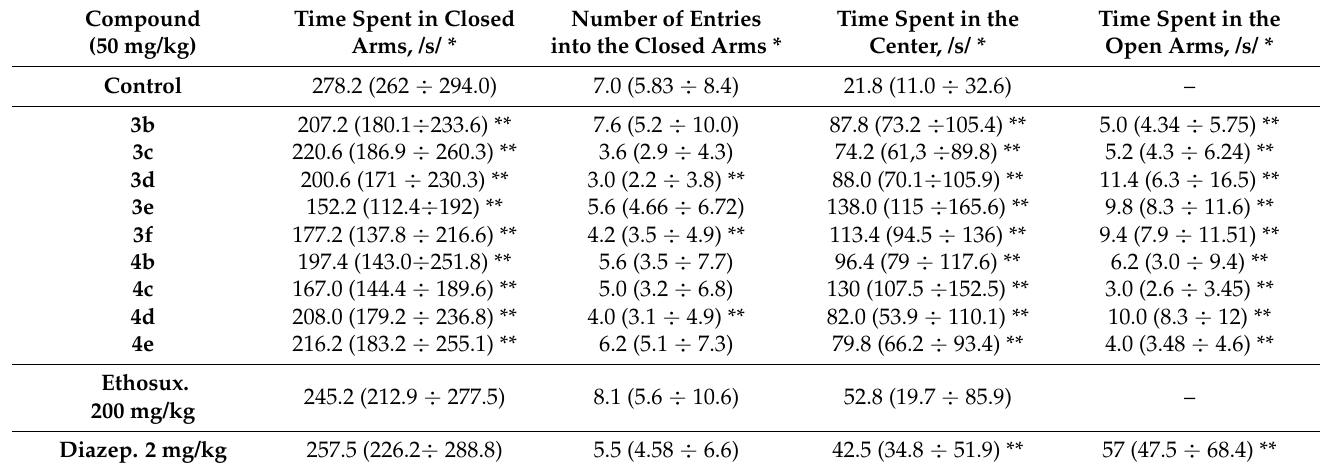
Table 5. Effect of compounds ( 3b, 3c, 3d, 3e, 3f, 4b, 4c, 4d and 4e ), on the state of ”fear and despair” of mice in the EPM model (observation time 5